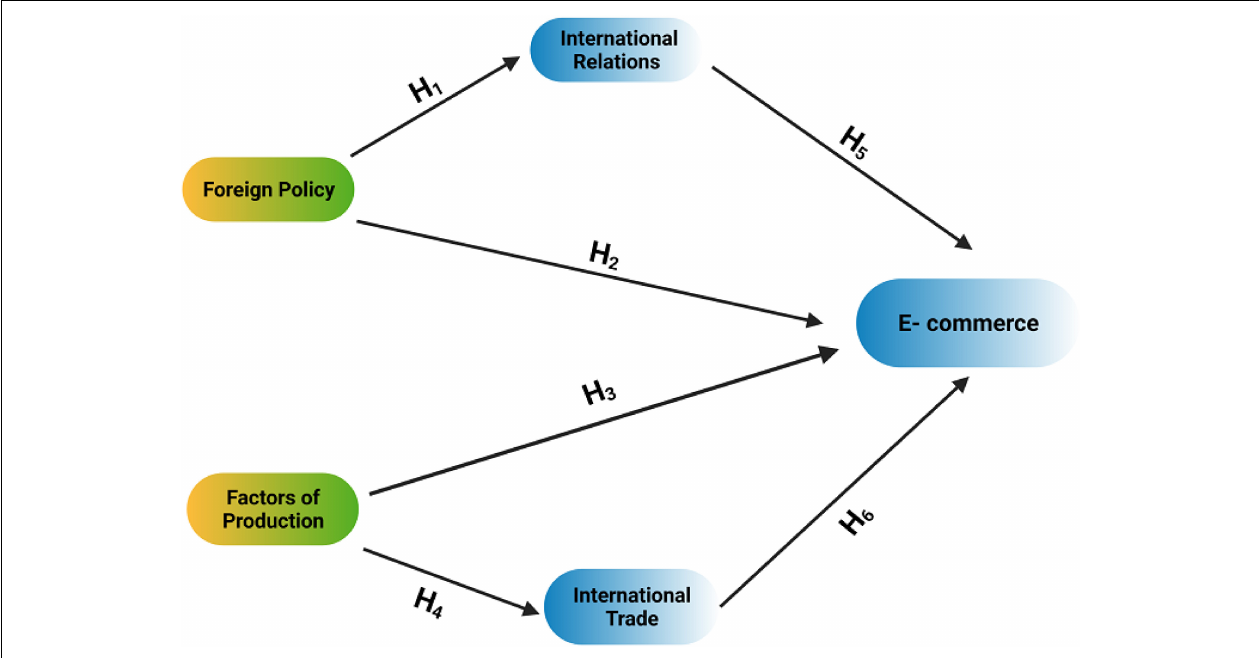
FIGURE 1 | Conceptual model.